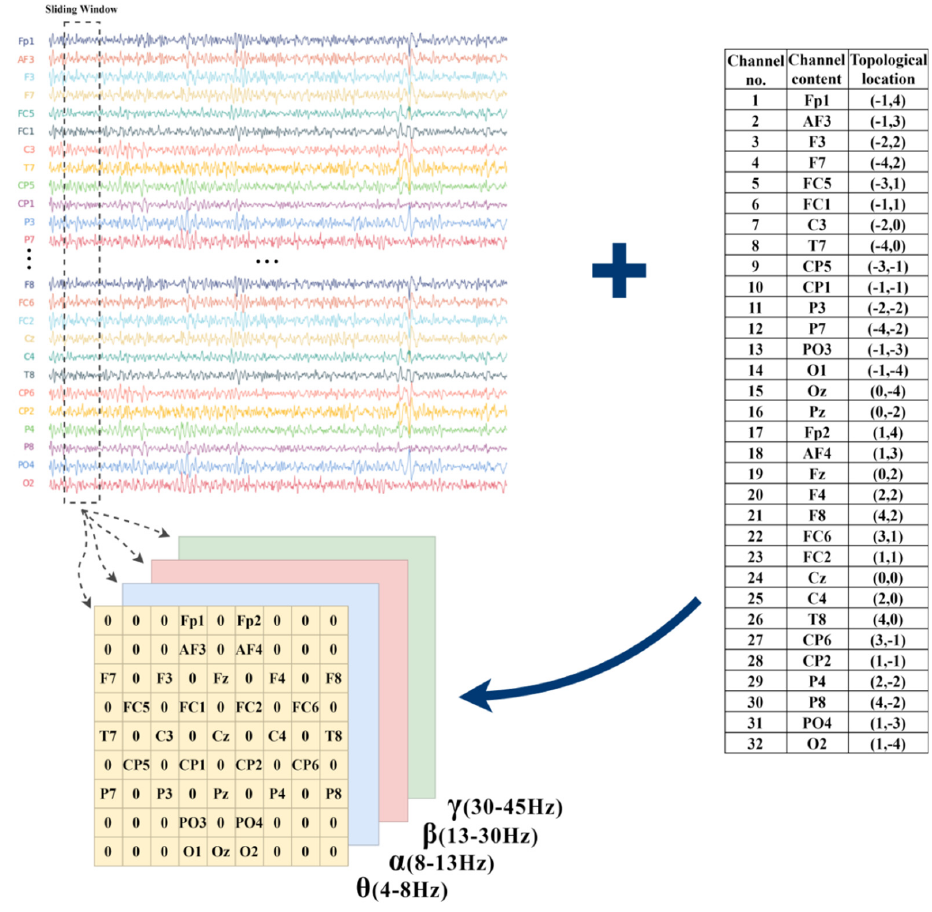
Figure 3. The construction of multi-band EEG topology maps.